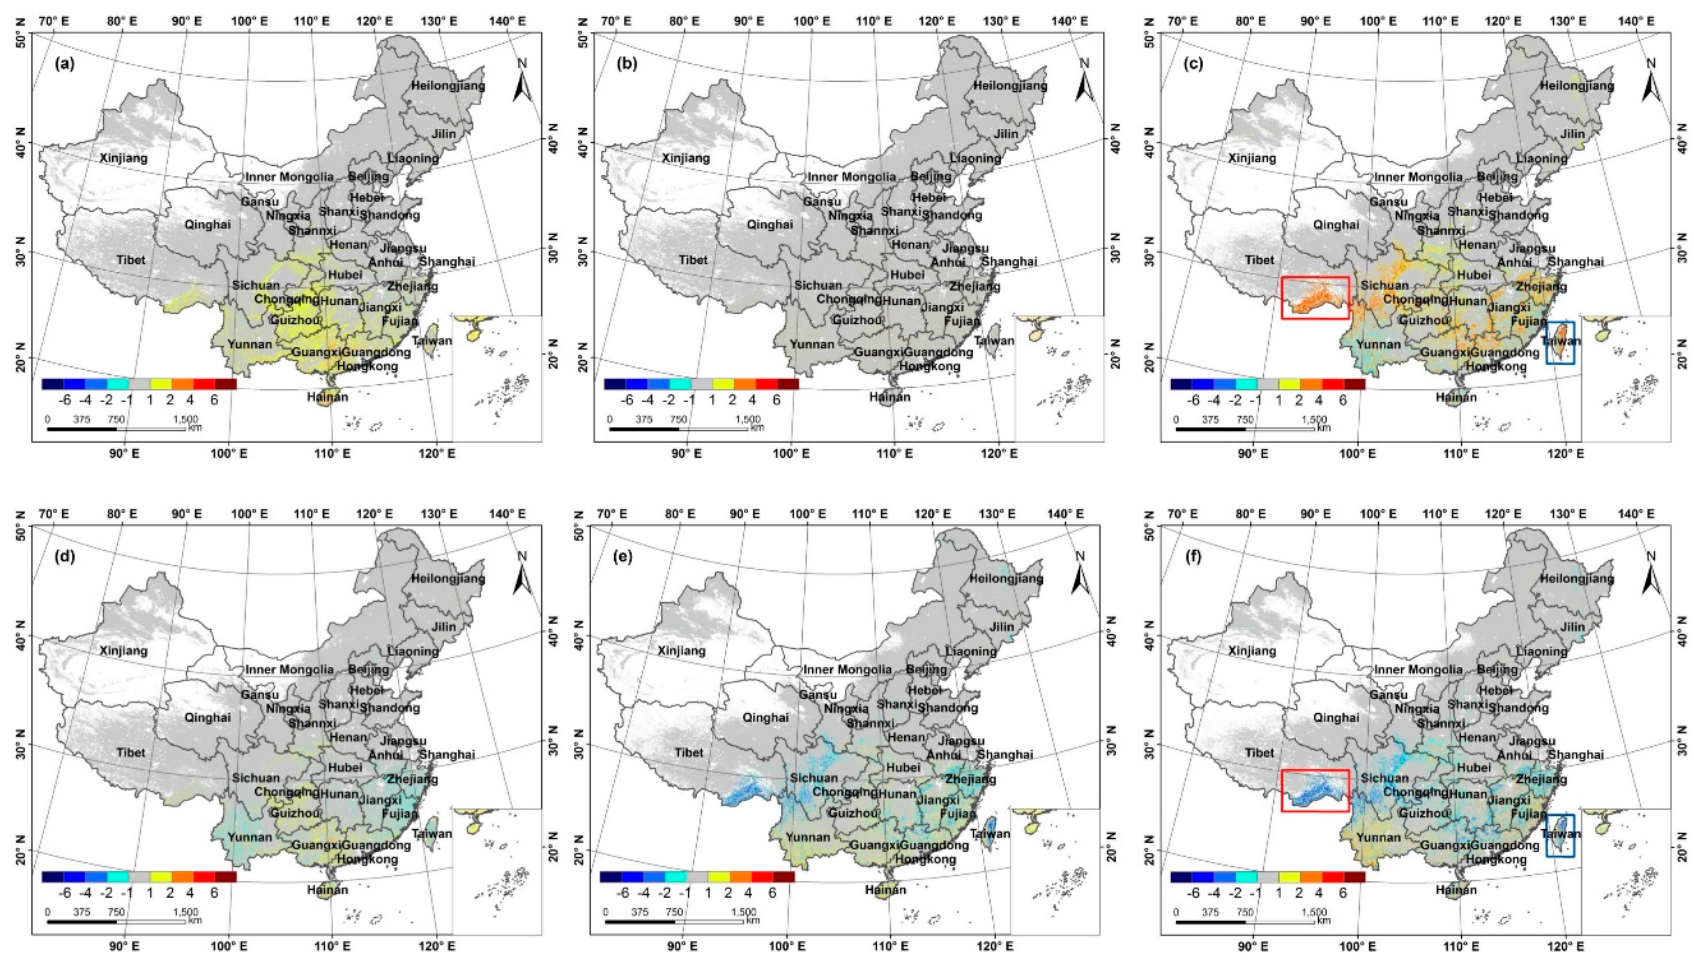
Figure 7. Spatial difference between each pairs of LAI products: ( a ) GLASS-MODIS; ( b ) GLOBALBNU-MODIS; ( c ) GLOBMAP-MODIS; ( d ) GLASS-GLOBALBNU; ( e ) GLASS-GLOBMAP; ( f ) GLOBALBNU-GLOBMAP.